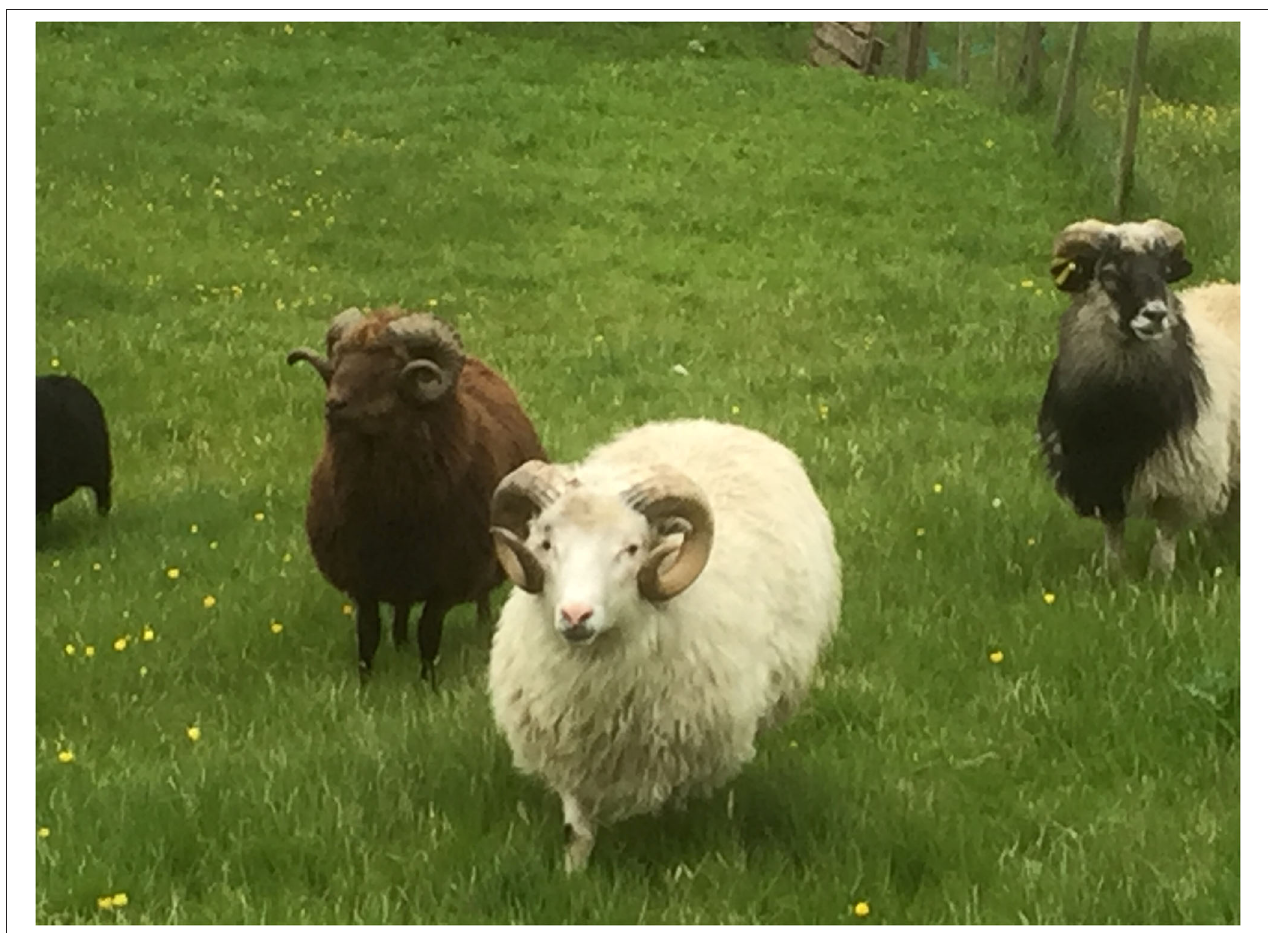
FIGURE 1 | Faroese sheep in Gjógv (Photo Osva Olsen, July